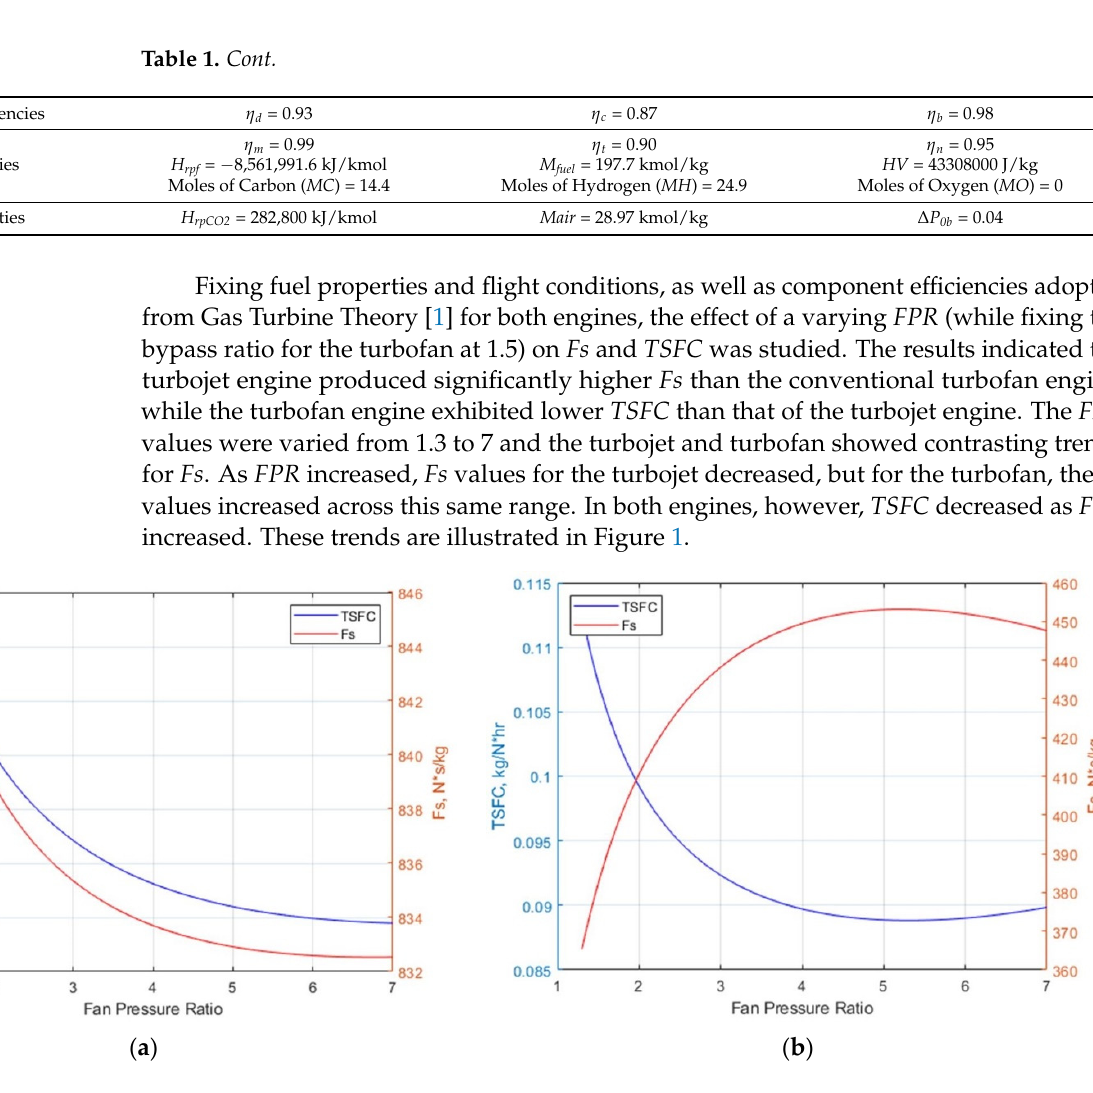
Figure 1. Plots of performance vs. FPR for [6] ( a ) turbojet and ( b ) turbofan. In subsequent analyses of the turbofan, as BPR decreased from 1.5 to 0.1, both Fs and TSFC increased, and the turbofan exhibited increasingly similar trends to that of the turbojet. This served as evidence as to why low-bypass turbofans are used in military aircraft applications as they perform comparatively while still improving on some of the issues faced by turbojet engines such as high fuel consumption in comparison to their turbofan counterparts. The next step in this analysis was to investigate the differences between two similar turbofans: the conventional turbofan and the military-style turbofan. To reiterate, both configurations were studied with the same design points, component efficiencies, ambient conditions, and fuel characteristics. For every BPR investigated, ranging from 0.1 to 1.5, the military-style turbofan outperformed the conventional turbofan with respect to both Fs and TSFC as well as propulsive, thermal, and overall efficiencies. This increase in performance with respect to Fs and TSFC is due to the fundamental thrust gain that occurs when the hot and cold streams mix to produce a stream of intermediate temperature. Tables 2–4 show some of the comparisons in their performance.